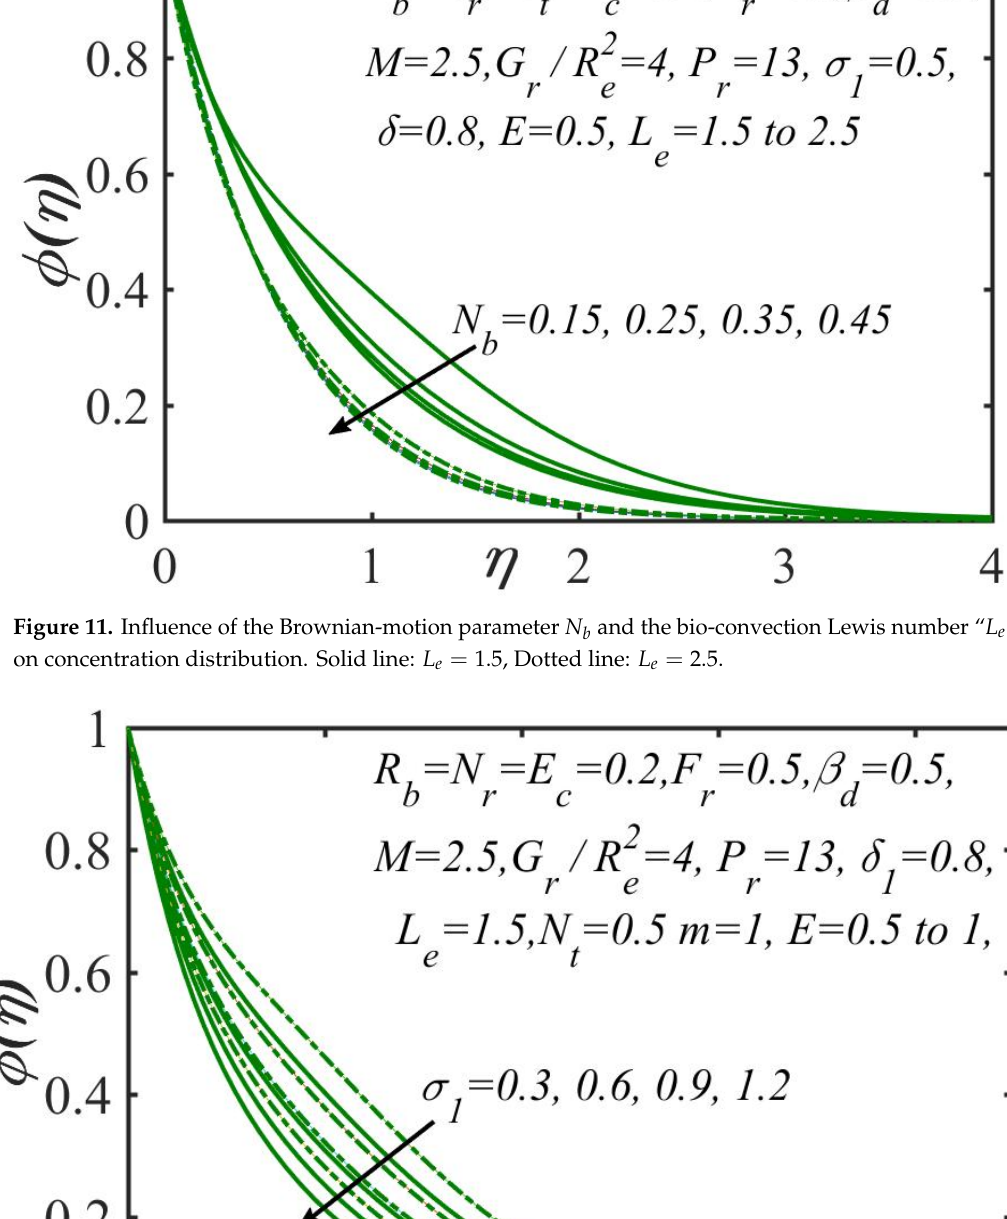
Figure 10. Influence of the bio-convection Lewis number (cid:1838) (cid:3032) and the thermophoresis parameter “ (cid:1840) (cid:3047) ” on concentration distribution. Solid line: (cid:1840) (cid:3047) = 4 , Dotted line: (cid:1840) (cid:3047) = 8.